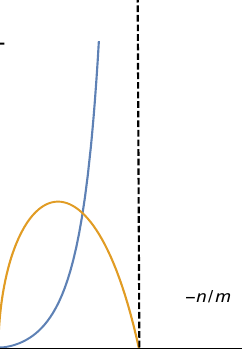
Figure 5 . The orange lines are extremal curves in the (cid:28) -plane for the ( m; n ) saddle (where J , Q , and S are all real). The blue line plots the normalized entropy S ( m;n ) ( m;n ) extremal curve. For every n , with m > 0, gcd( m; n ) = 1, and such that ( m + n ) mod 3 6 = 0, m the normalized entropy grows to + 1 when the extremal curve approaches (cid:0) n (( m + n ) mod 3 = 1), or from the right (( m + n ) mod 3 = (cid:0) 1).